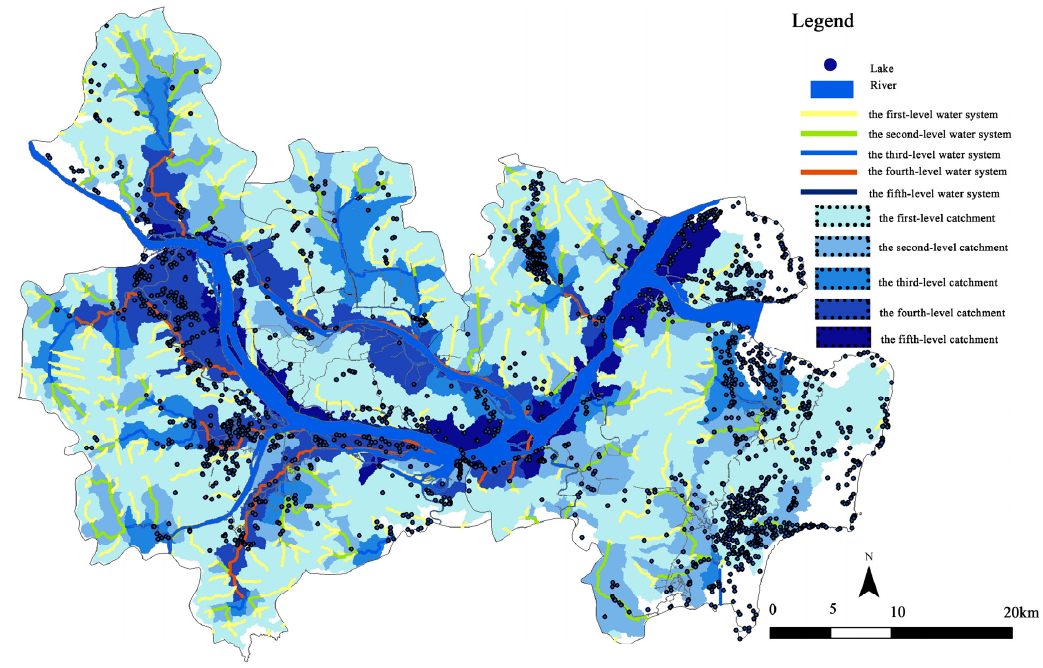
Figure 7. Water systems in Fuzhou, China.